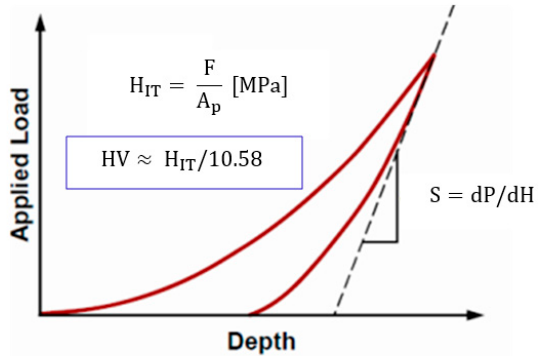
Figure 3. Instrumental microhardness test—the Oliver and Pharr method.